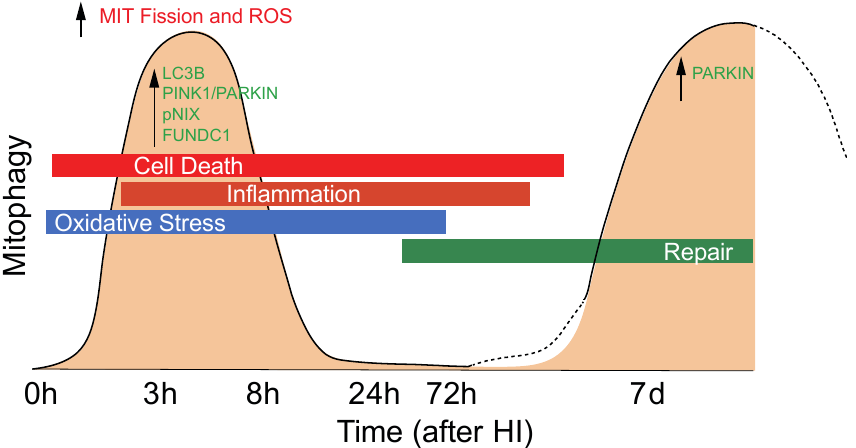
Figure 12. Hypothetical scheme for mitophagy. Following HI, mitophagy was transiently upregulated at 3 h after HI followed by a second wave at 7 days after HI. Western blotting results suggest both PINK1/Parkin-dependent and -independent mechanisms, including NIX and FUNDC1 are up-regulated immediately after HI, whereas Parkin-mediated mitophagy predominated 7 days after neonatal HI.